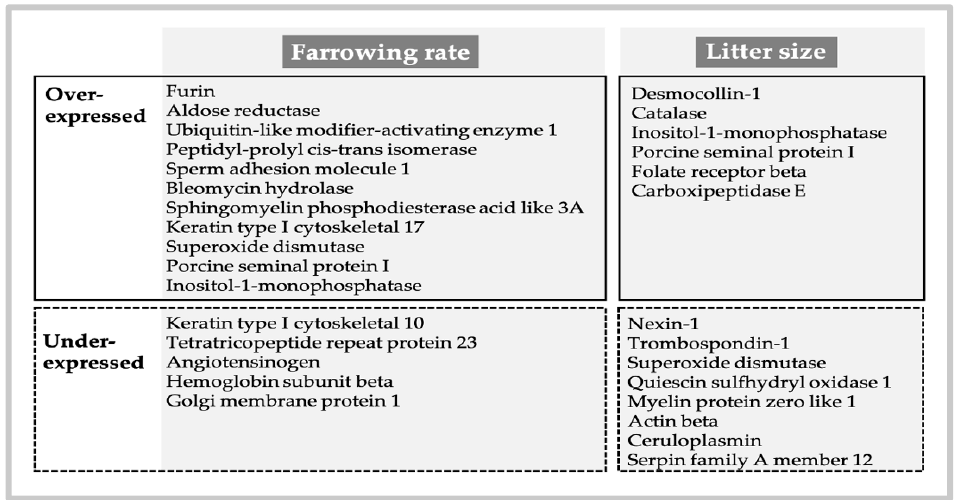
Figure 2. Over- and underexpression of less abundant specific seminal plasma proteins in the ani- mal model pig ( Sus scrofa ) analyzed using iTRAQ-based quantitative proteomics and their relation to fertility, as farrowing and prolificacy (litter size) (modified from [33,96,97].